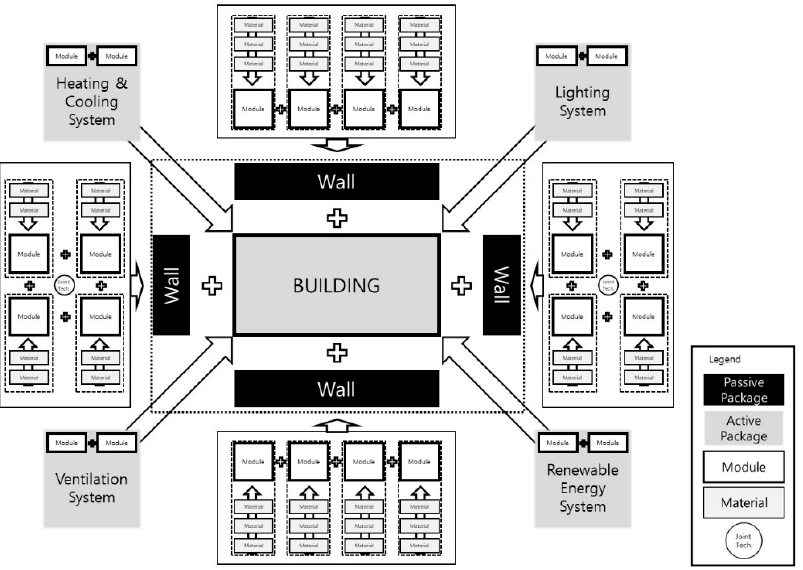
Figure 1. Technical package composition in the building.